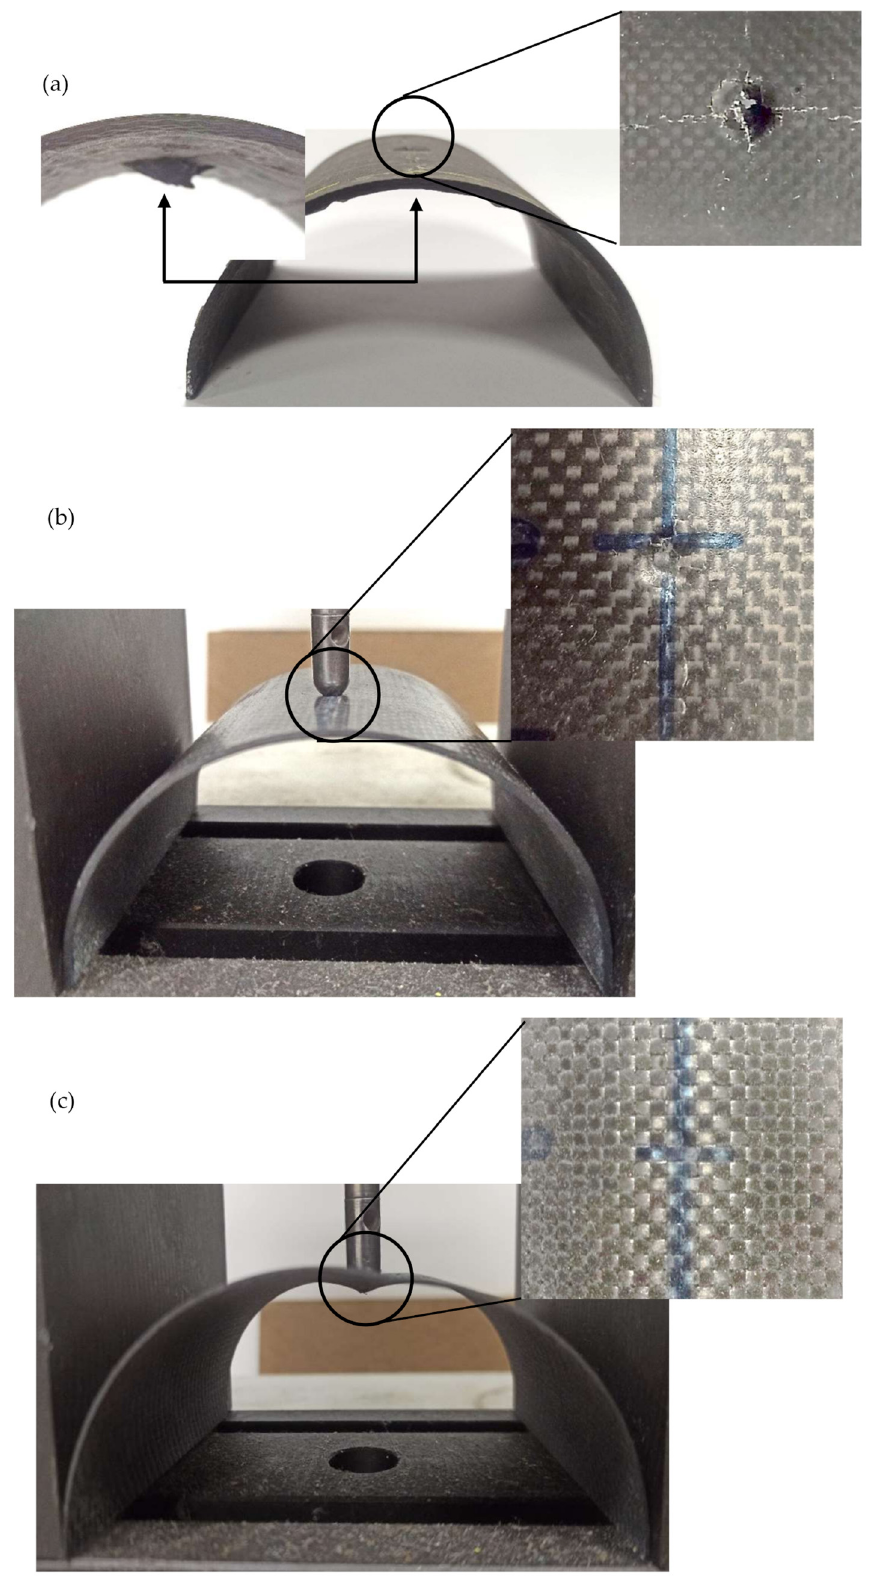
Figure 5. Failure mechanisms for shells with: ( a ) eight layers; ( b ) six layers: ( c ) four layers. Regarding the shells with six layers of carbon fabric (Figure 5b), the damage